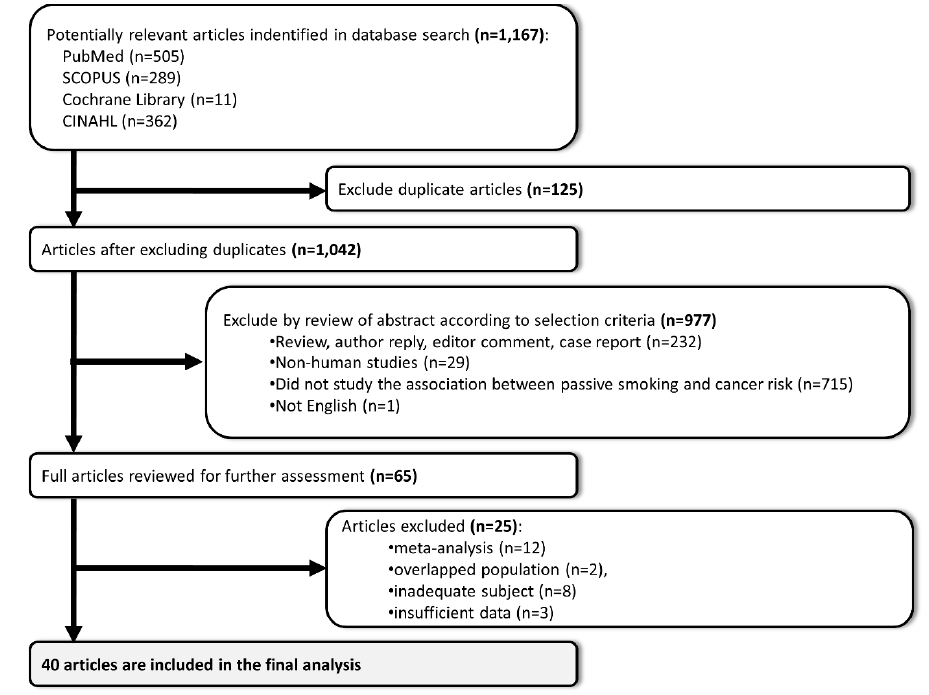
Figure 1. Summary of the studies selection process.